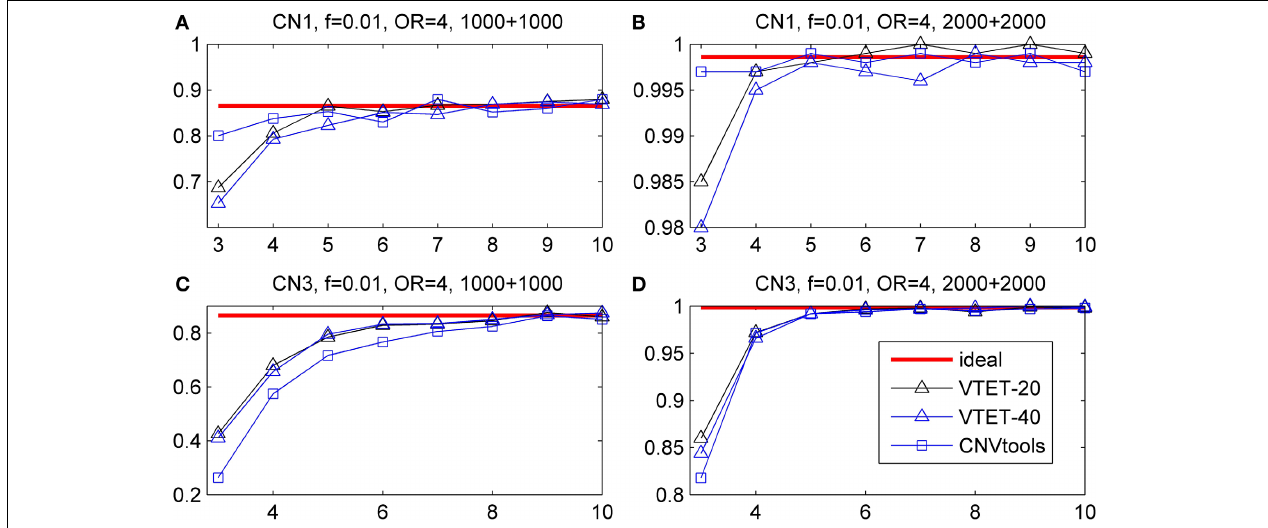
FIGURE 5 | Statistical power for detecting the association of recurrent CNVs with the same boundary. f is the frequency of CNVs in the general population. OR is odds ratio. Powers were calculated based on the significance level α = 0 . 001. The x-coordinate is the number of probes